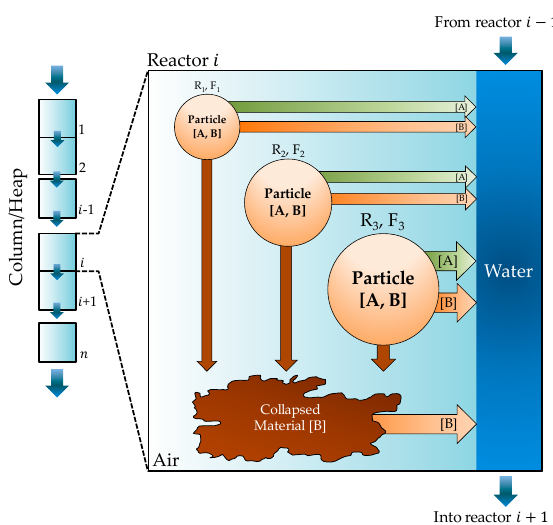
Figure 4. Schematic representation of the material flow that occurs in the small reactor i . Three radii: R 1 , R 2 and R 3 , and mass fractions: F 1 , F 2 and F 3 are considered. The particles are spheres and composed homogeneously by two soluble species: A and B.